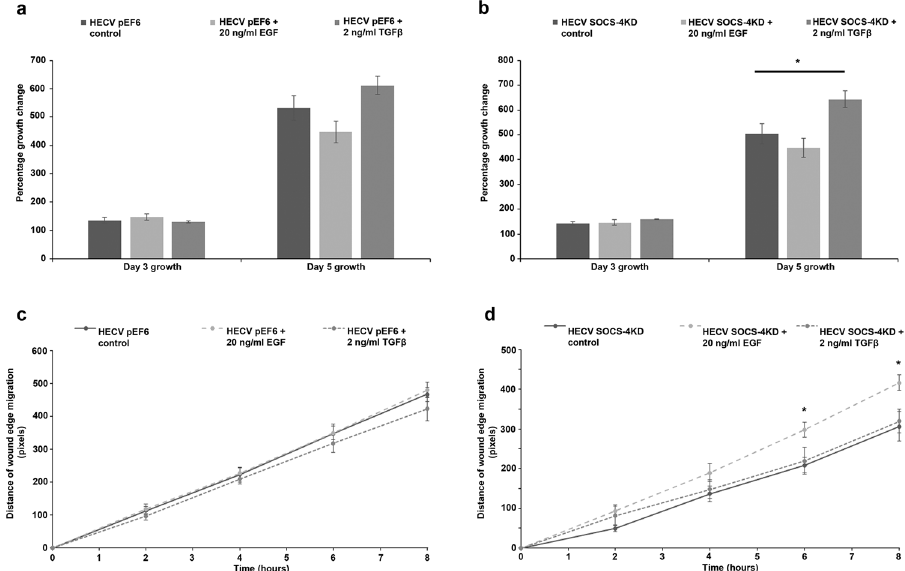
Figure 7. Impact of SOCS-4 suppression on the proliferative and migratory responses of HECV endothelial cells to EGF and TGF β . Proliferative rates of ( a ) HECV pEF6 and ( b ) HECV SOCS-4 knockdown cells in addition to 20 ng/ml EGF or 2 ng/ml TGF β were assessed using a MTT growth assay over 3 and 5 days. Cellular migration in response to 20 ng/ml EGF and 2 ng/ml TGF β was also explored using a conventional scratch wound assay on ( c ) HECV pEF6 and ( d ) HECV SOCS-4 knockdown cells. Data shown are mean values of a minimum of three independent repeats, error bars represent the standard error of the mean and * represents p <